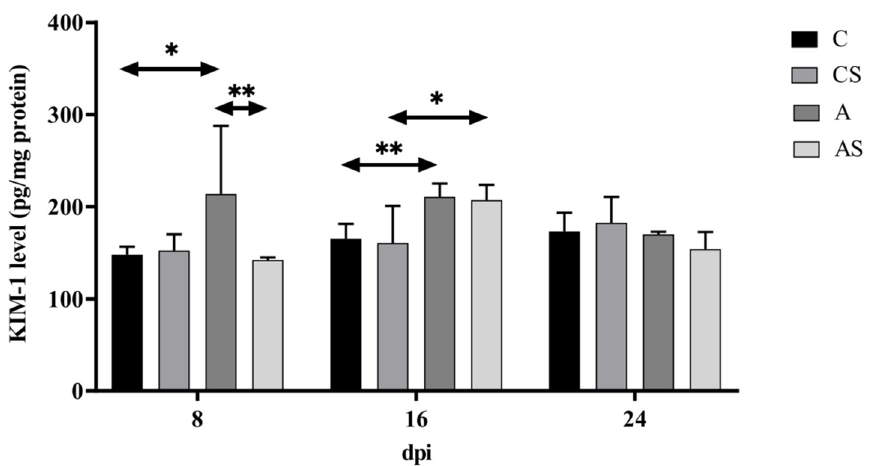
Figure 1. The level of kidney injury molecule-1 (KIM-1) in the kidneys of mice infected with Acanthamoeba spp. KIM-1 was determined using ELISA and it is expressed in pg/mg protein. Data represent the means ± standard deviation for six independent experiments. (A: Immunocompetent mice infected with Acanthamoeba spp.; AS: Immunosuppressed mice infected with Acanthamoeba spp.; dpi: Days post Acanthamoeba spp. infection; C: Immunocompetent mice uninfected with Acanthamoeba spp.; CS: Immunosuppressed mice uninfected with Acanthamoeba spp.; statistically significant differences * p < 0.05; ** p < 0.01).